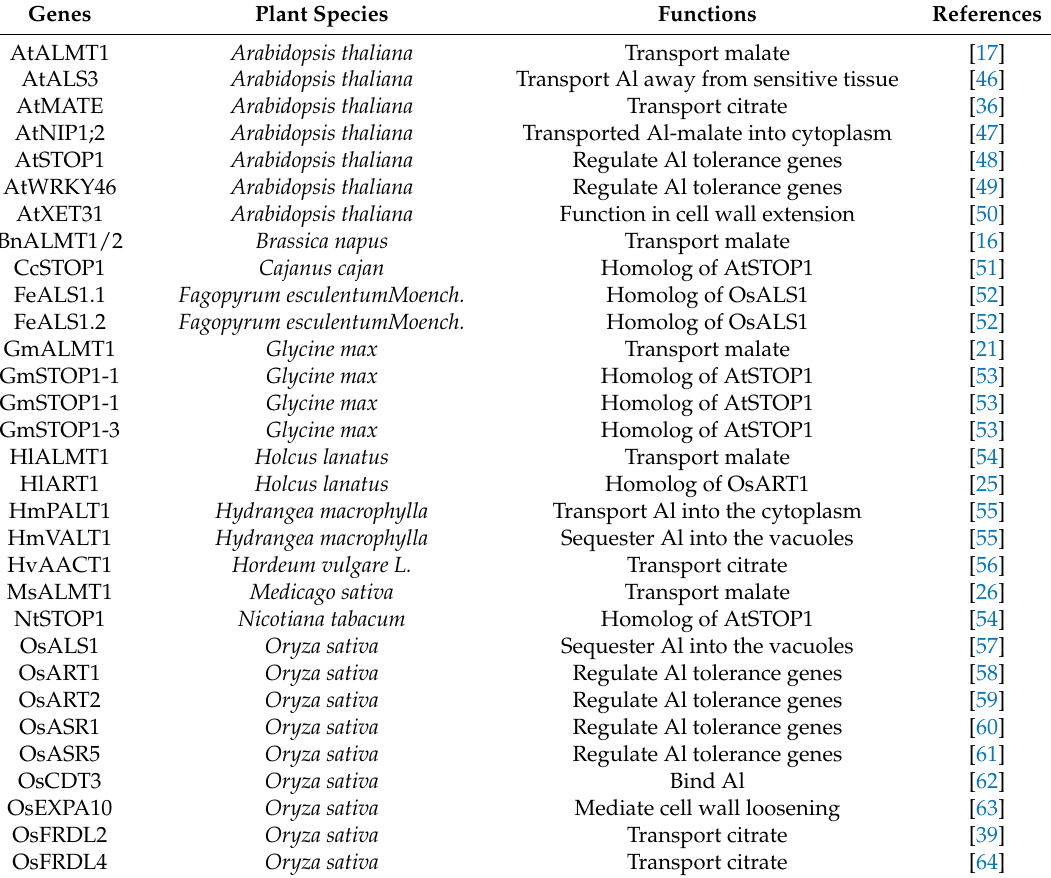
Table 1. The list of Al tolerance genes identified in